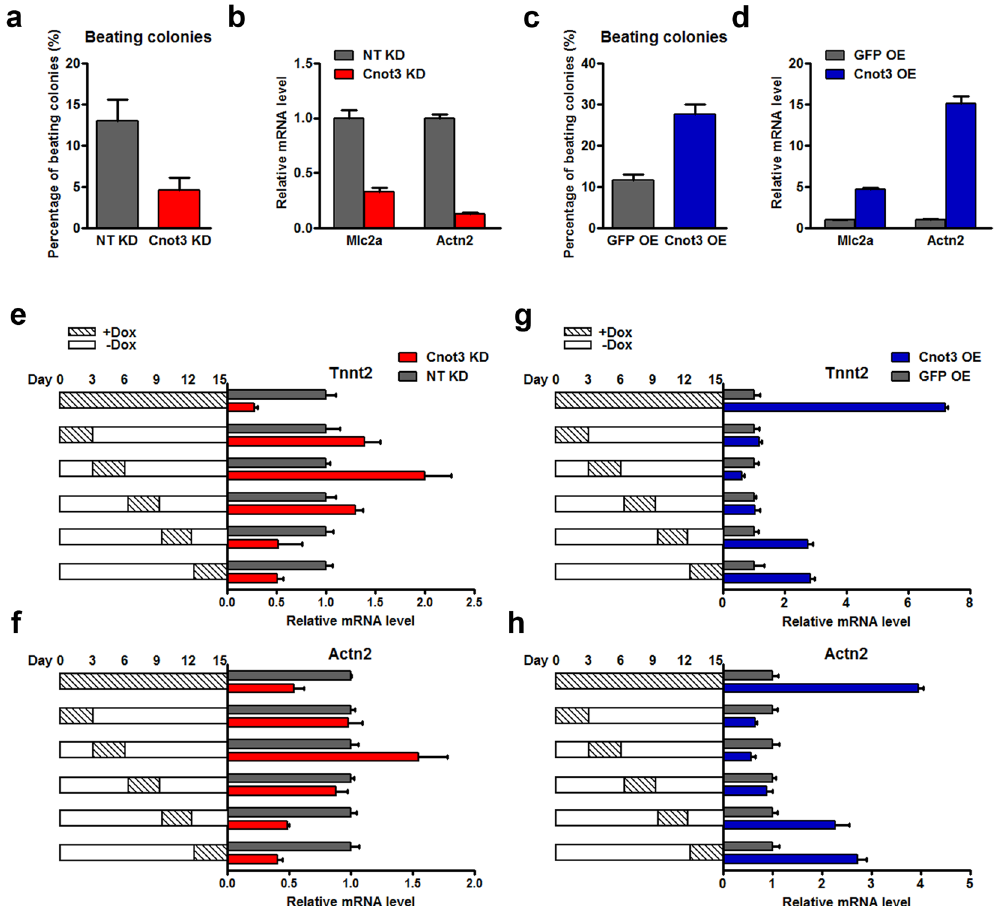
Figure 1. Cnot3 is required for cardiac differentiation. ( a ) NT shRNA-(shNT) or Cnot3 shRNA (shCnot3)- transduced human ESCs were induced to differentiation (see Methods for details) for 12 days, and the amount of beating colonies were counted and plotted as mean ± SEM from three independent experiments. ( b ) The expression of cardiac specific gene was determined by qPCR 12 days after hESCs differentiation. β -actin was used as endogenous control and values were plotted as mean ± SEM from three independent experiments. ( c ) GFP or Cnot3-overexpressing human ESCs were induced to differentiation (see Methods for details) for 12 days, and the amount of beating colonies were counted and plotted as mean ± SEM from three independent experiments. ( d ) The expression of myocyte specific gene was determined by qPCR 12 days after hESCs differentiation. β -actin was used as endogenous control and values were plotted as mean ± SEM from three independent experiments. ( e , f ) Inducible-shCnot3 or Inducible-shNT hESCs were induced to differentiation, and doxycycline was added during the differentiation process at the indicated time points. The effects of Cnot3 depletion on myocyte specific gene expression at different stages were determined by qPCR. β -actin was used as endogenous control and values were plotted as mean ± SEM from three independent experiments. ( g , h ) Inducible-Cnot3 or Inducible-GFP overexpression hESCs were induced to differentiation, and Doxycycline was added during the differentiation at the indicated time points. Effects of Cnot3 depletion at different stage on myocyte specific gene expression were determined by RT-qPCR. β -actin was used as endogenous control and values were plotted as mean ± SEM from three independent